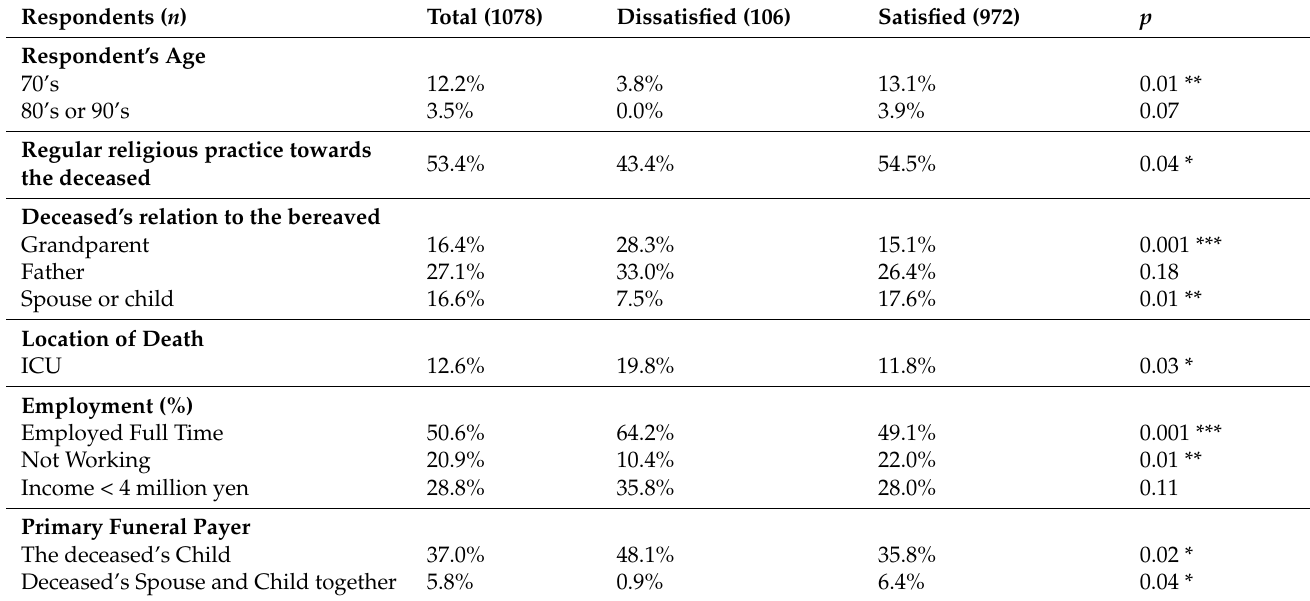
Table 2. Socioeconomic variables connected to funeral satisfaction/dissatisfaction.